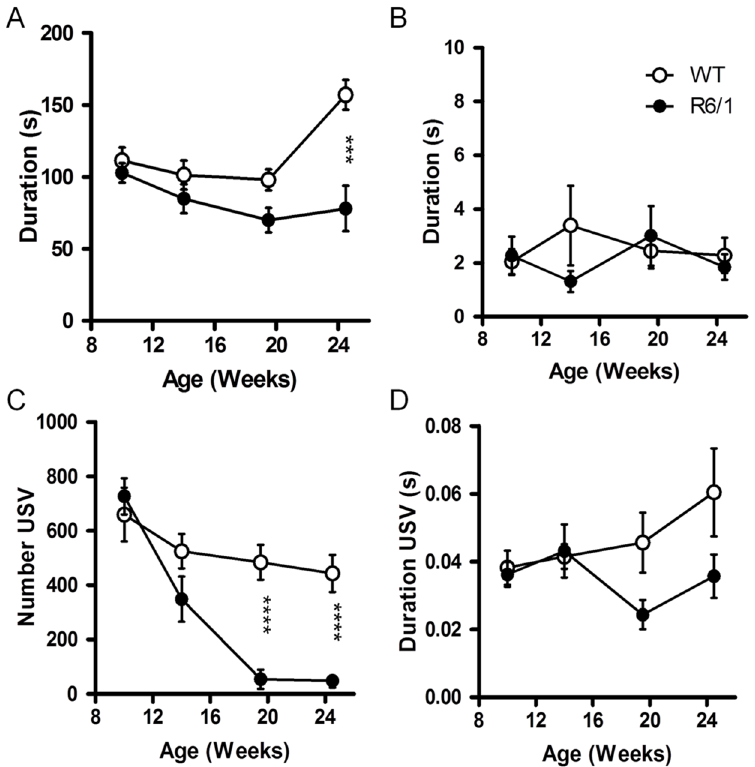
Fig 7. Social behaviors in R6/1 mice. Time spent in social affiliative behaviors (A) and non social behaviors (B), number of ultrasonic vocalization (C) and their mean duration (D) in both groups of mice at different ages. *** R6/1 mice significantly different from age-matched WT littermates at p <